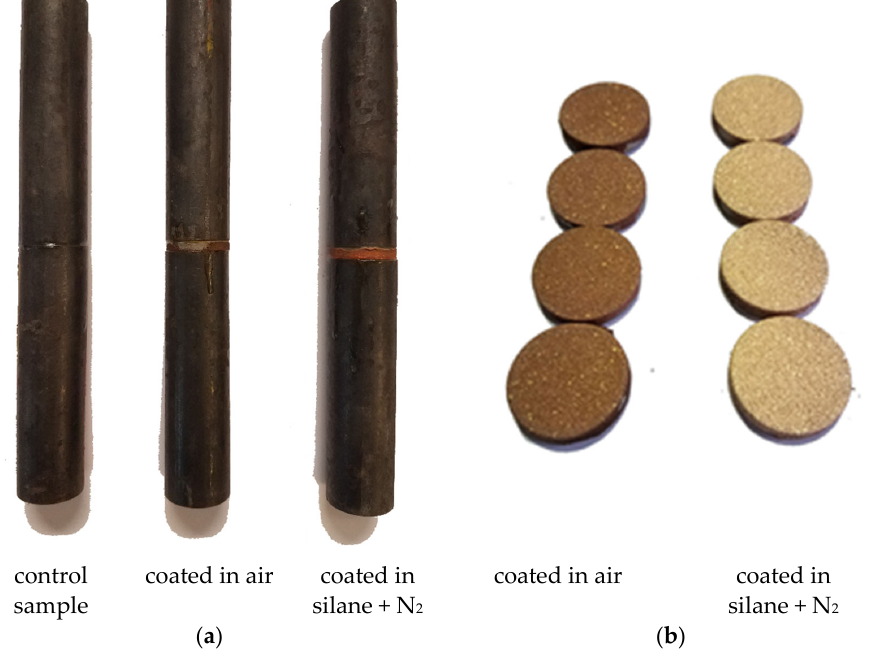
Figure 3. Adhesive tensile strength specimens in accordance to DIN EN ISO 14916: ( a ) used sample type B setup; ( b ) 25 mm diameter S235JR discs coated with copper in air and in an atmosphere with an oxygen content of less than 1 × 10 − 26 vol. ‐ %.